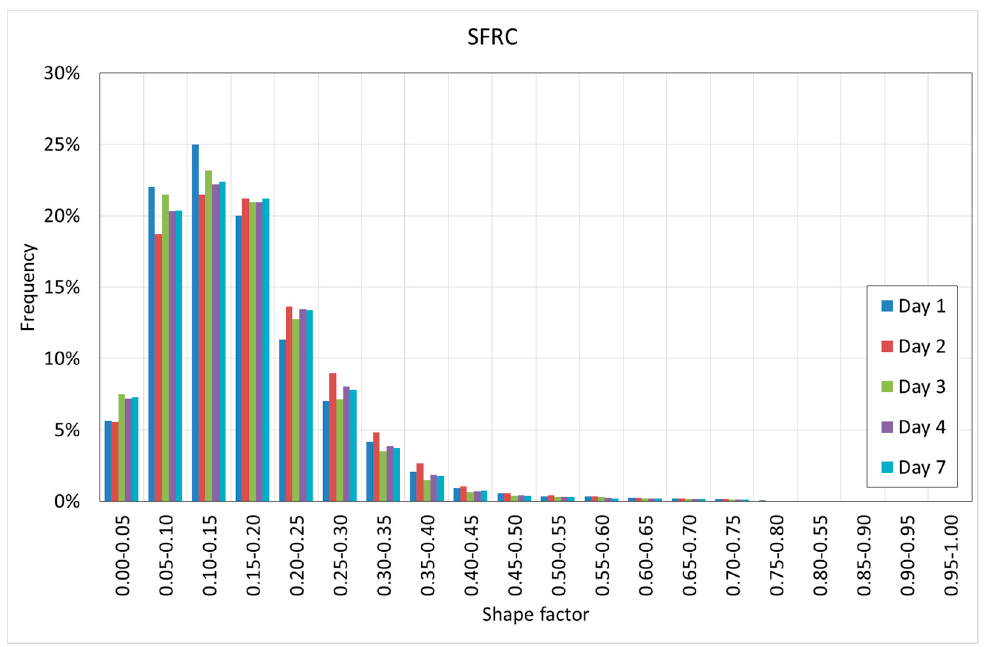
Figure 21. Histogram of the shape factor of PC.